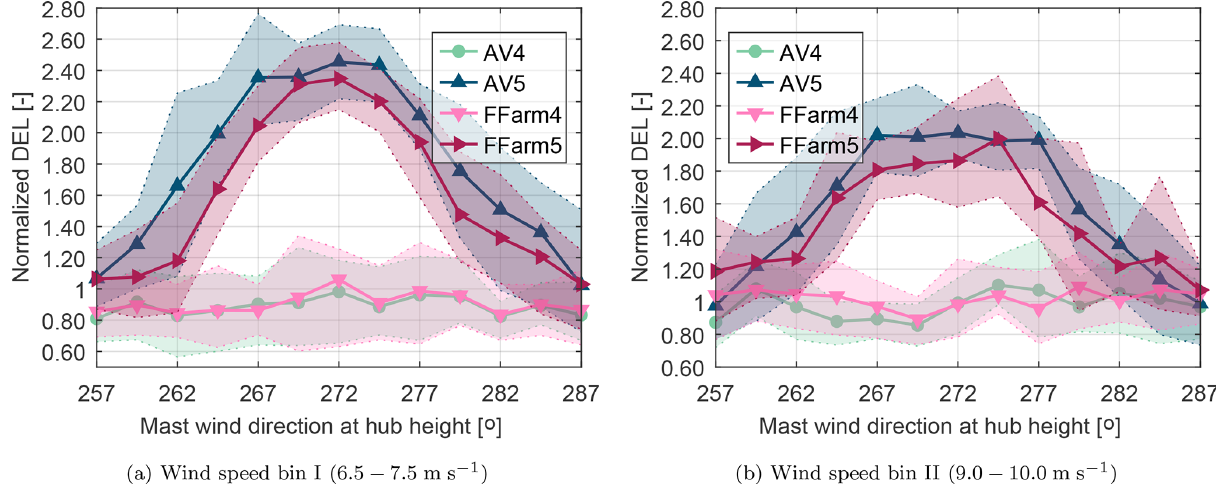
Figure 9. Comparison of the tower-base bending moment in the fore–aft direction in waked conditions between measurements (AV4, AV5) and simulations (FFarm4, FFarm5). Statistics are shown as mean values per wind direction bin. The shaded area indicates the 15th and 85th